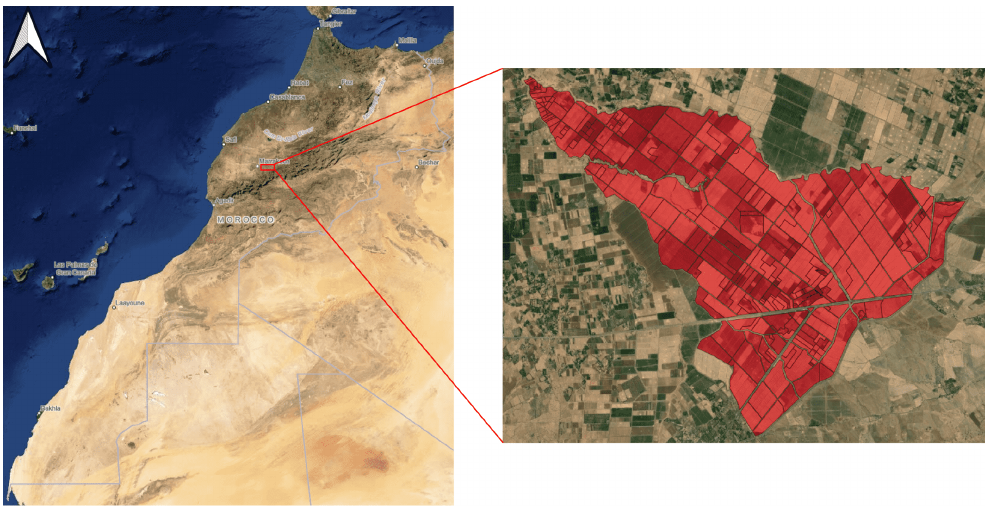
Figure 1. The location of the R3 district study area in Morocco [16].